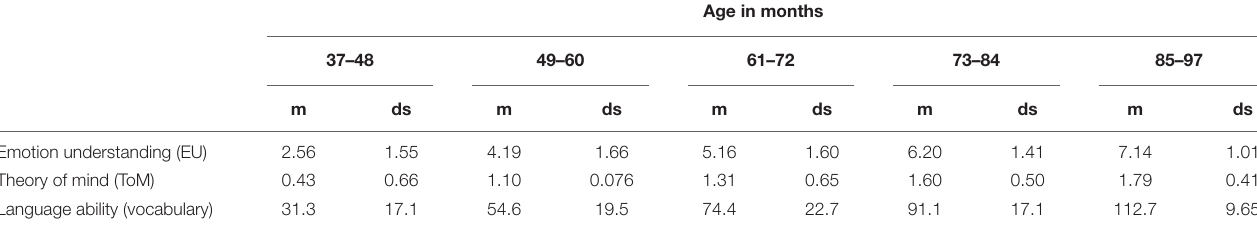
TABLE 2 | Descriptive statistics by children’s age group ( N = 389).